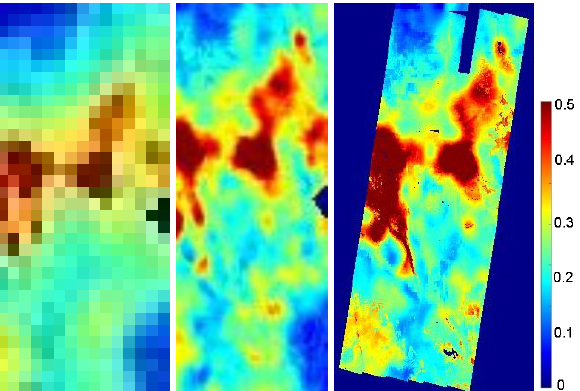
Figure 4. Soil moisture images in cm 3 cm − 3 from eastern Africa (specifically South Sudan) at 36 km resolution ( left ), 9 km resolution ( center ), and 3 km resolution ( right ), from day 300 in 2016. The estimated soil moisture is extracted from rSIR-enhanced brightness temperature images. The reduced coverage in the 3 km image is a result of limited ancillary data availability from the SMAP-Sentinel 3 km soil moisture data set.